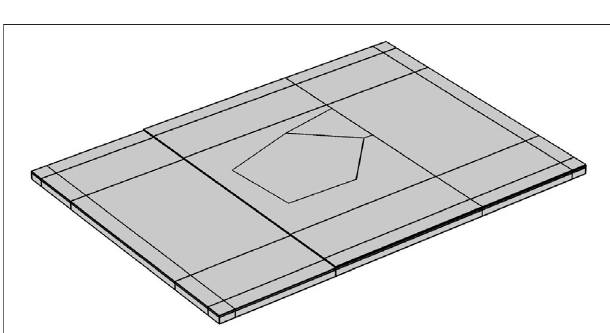
FIGURE 3 | 3D fi nite element model of the